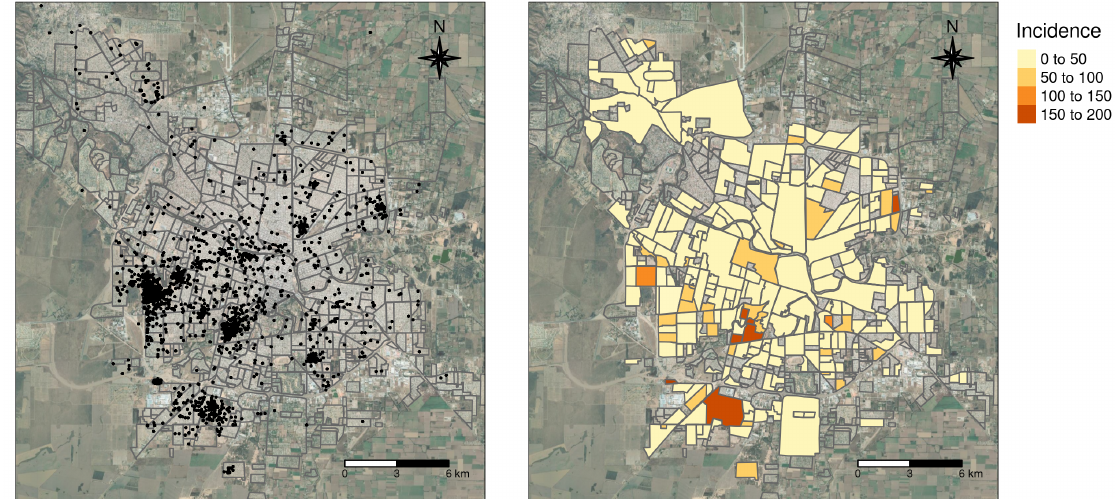
Figure 8. Distribution of autochthonous dengue cases ( left ) and incidence in 10,000 people by neighborhood ( right )